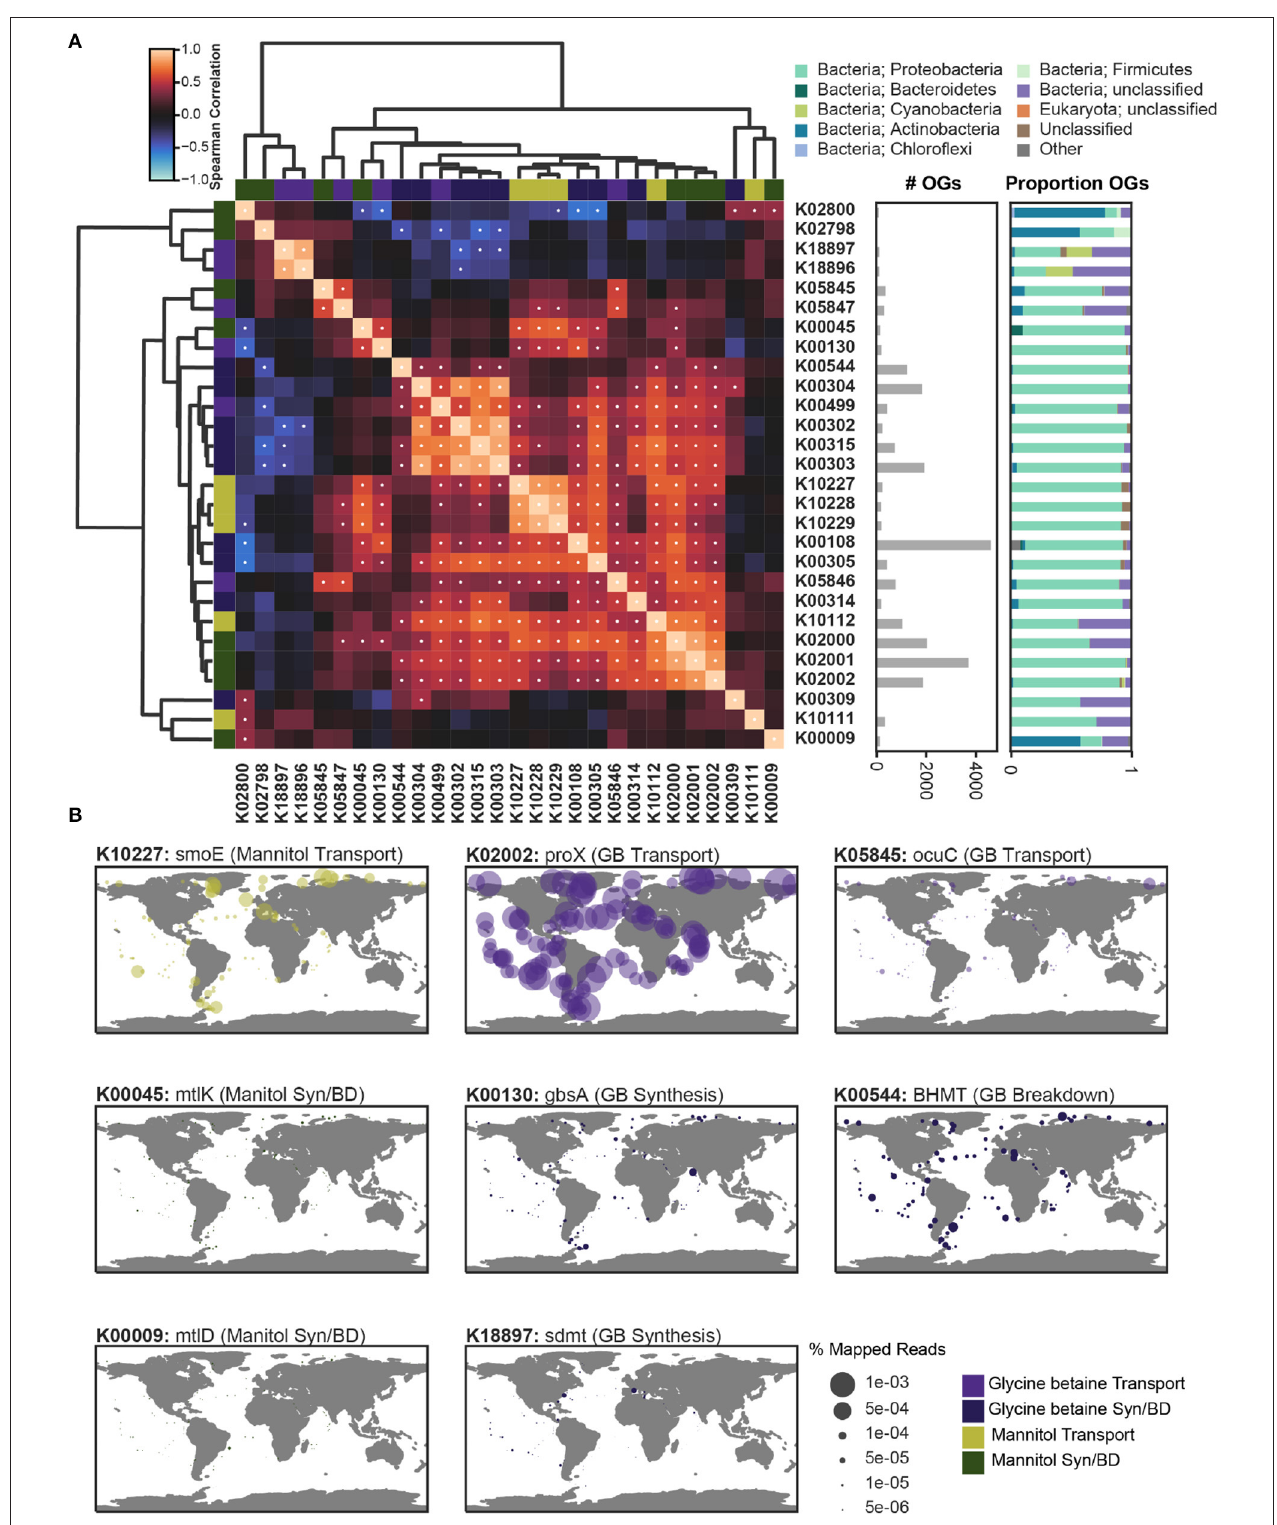
FIGURE 5 | The co-occurrence, taxonomic profile, and global abundance of key orthologs involved in the synthesis, breakdown, and transport of mannitol and glycine betaine. The metatranscriptomic abundance of key orthologs involved in the processing of mannitol (green) and glycine betaine (purple) was assessed